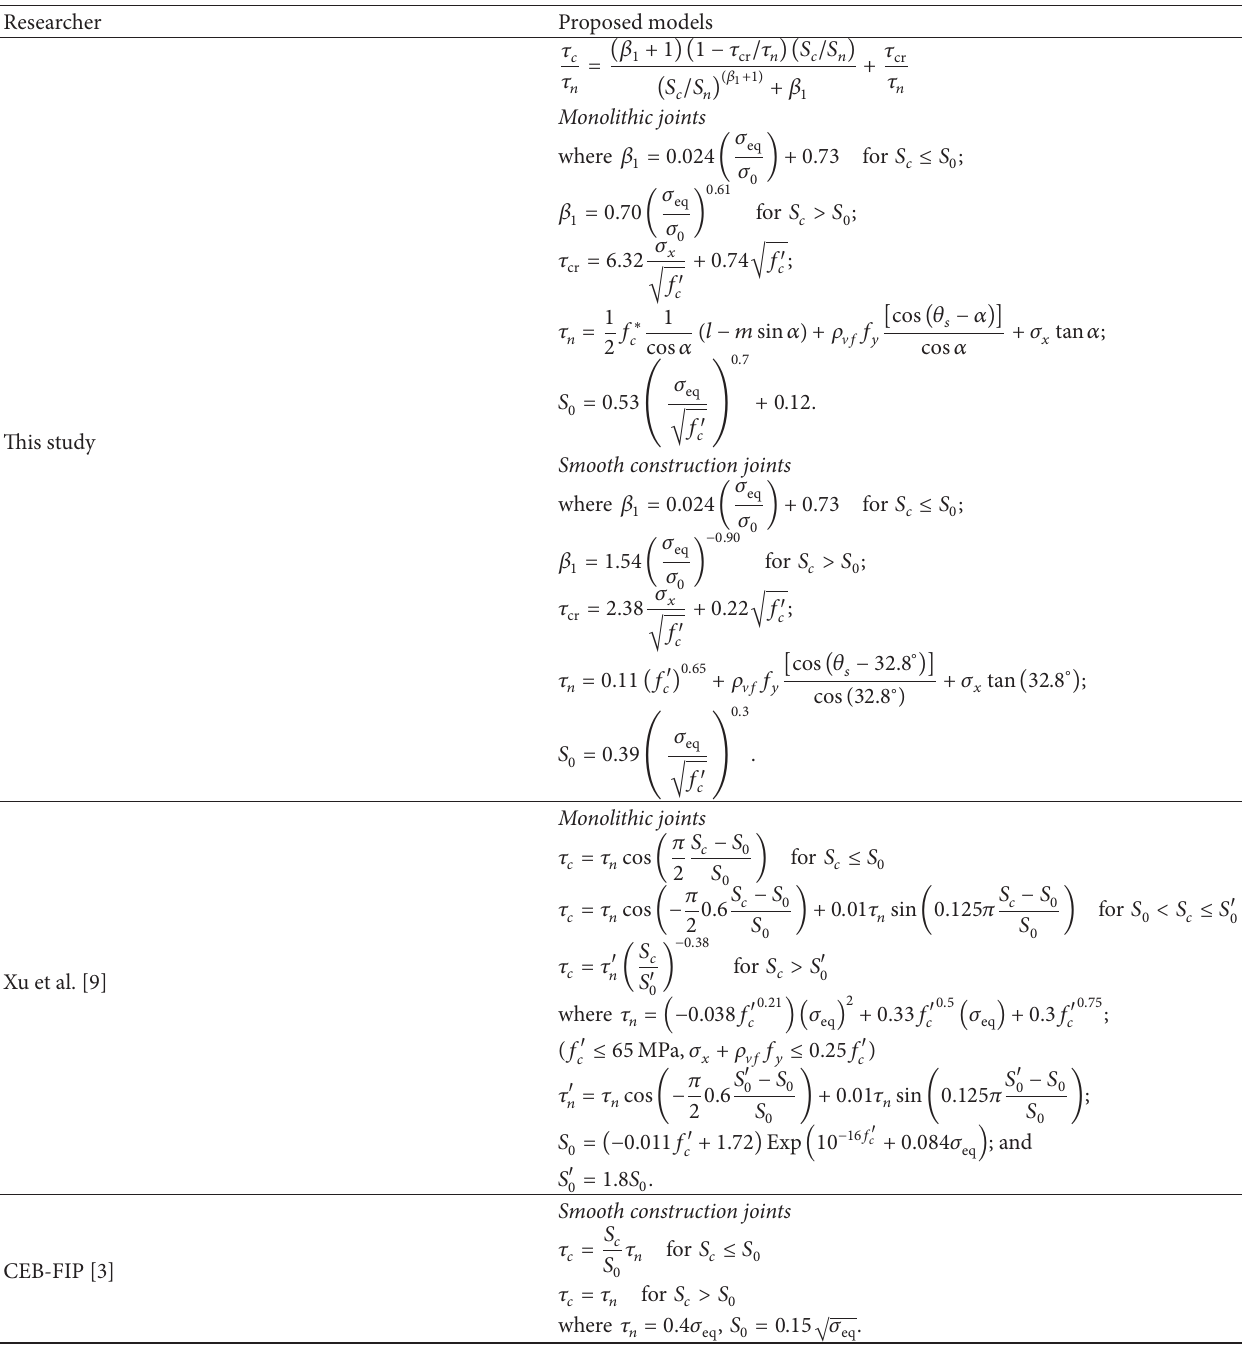
Table 1: Summary of proposed models for shear stress-relative slip